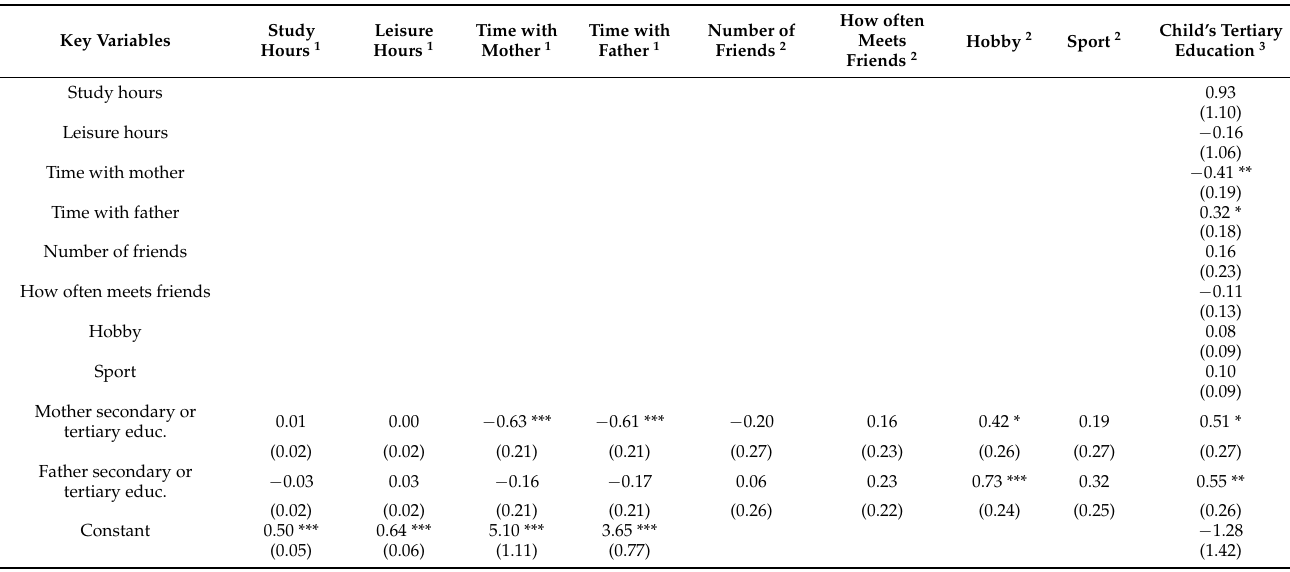
Table 3. Generalised structural equation model (GSEM) on young people’s time use and educational achievement. FTUS 1979, girls aged 10–18. First step models testing for daughters’ time use and social connectedness in 1979, n = 393. Full model tested for education achieved by 40, n = 355.